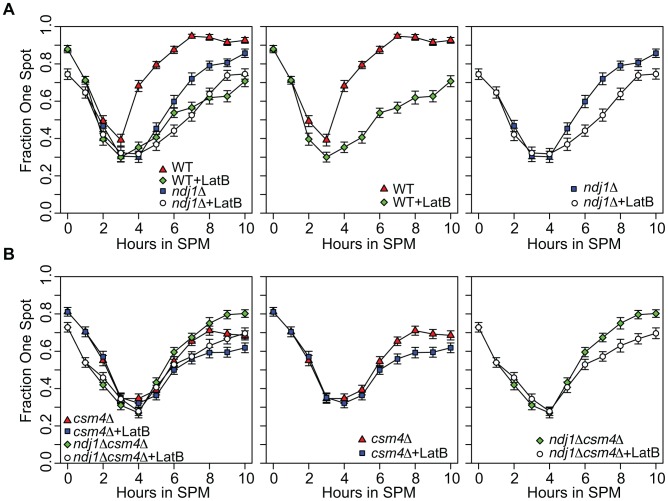
Homolog pairing kinetics in wild-type, ndj1Δ, csm4Δ, and ndj1Δ csm4Δ cells with and without Lat B treatment.Kinetics of pairing in cells with tetO arrays integrated at URA3, located 35 kb away from the centromere on chromosome V, and expressing tetR-GFP fusion protein. Homologs are considered paired if only one GFP can be visualized in the cells (n = 200) from each time point. Error bars represent the standard error of the percentage of cells paired for independent cultures for each mutant (n = 200). All strains carry the ndt80Δ mutation. A. Analysis of WT (center panel and left panel) and ndj1Δ (right panel and left panel) pairing kinetics in the presence or absence of Lat B. B. Analysis of csm4Δ (center panel and left panel) and ndj1Δ csm4Δ (right panel and left panel) pairing kinetics in the presence or absence of Lat B.